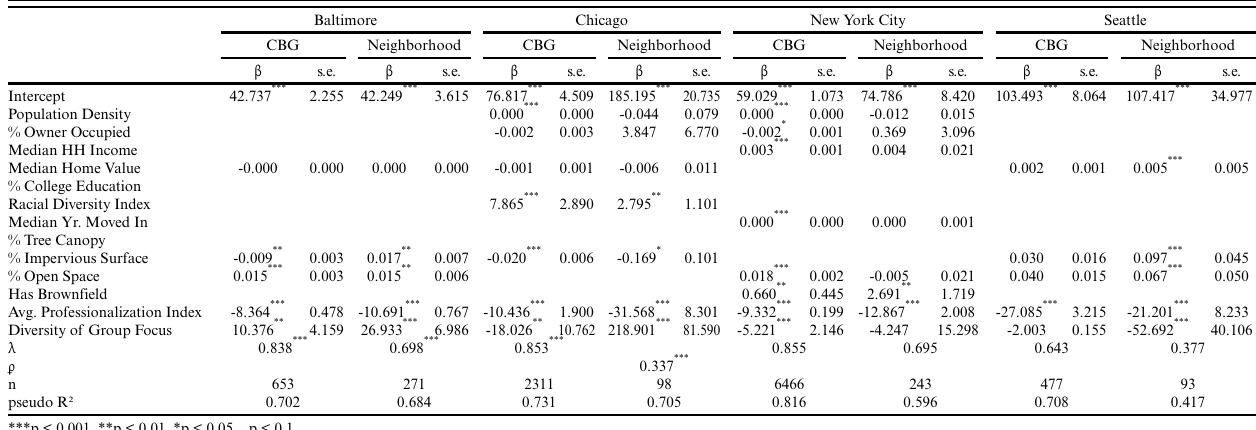
Table 5 . Spatial lag and/or error model Beta coefficients (and 95% confidence intervals) by study area city at census block group and neighborhood scales. Starred terms are significant (alpha =